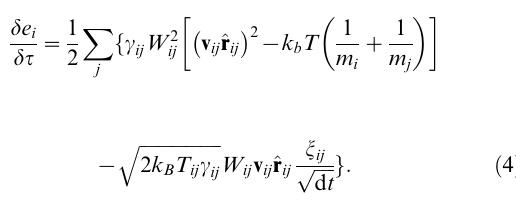
Figure 5. Snapshots of shock-wave propagation. Part a) shows the xy -projection of the simulation box; the hatched area on the left denotes a hard wall, i.e., the momentum-reflecting mirror (see text). All particles move left with particle velocity of v (cid:1) different representations, with the upper part indicating particle type (red=SPH, blue=MD), and the lower part representing a color-coding of local pressure (blue=low pressure, red=high pressure). Note that the average pressure in the MD region equals the pressure in the SPH region. Part b) shows the simulation at t (cid:1) ~ 12 : 5 , after the particles have moved and compressed against the left wall, with a corresponding pressure increase. The shock-wave front has reached the center of the MD particle region, as indicated by the pressure profile.